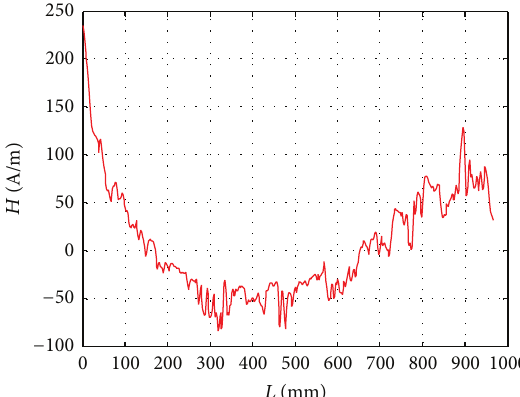
Figure 3: MMM signal of casing before stress